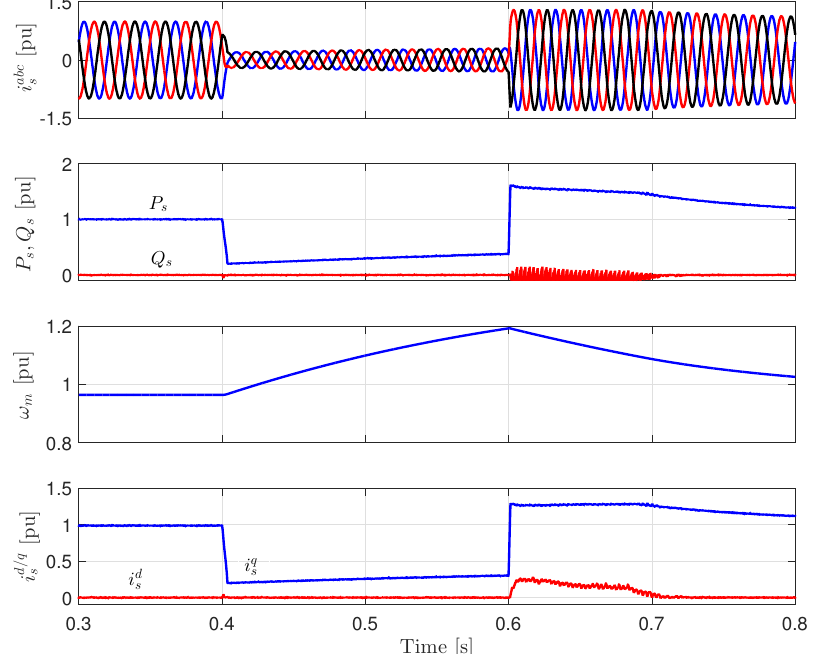
Figure 6. Performance of the GSC and DC-link during a three-phase fault with the proposed FRT strategy (from top ): grid voltages u abc o = ( u a o , u b o , u c o ) (cid:62) , GSC output currents i abc active and reactive power injected to the grid ( P f , Q f ), DC-link voltage u dc , and d - and q -axis currents of the GSC ( i d , i q ). f f